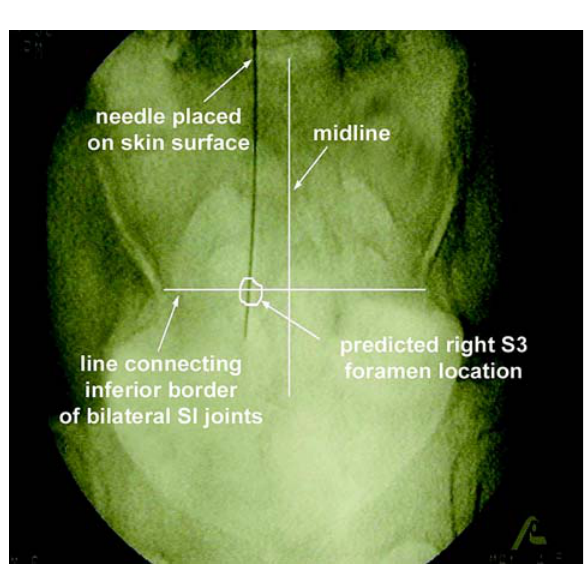
Figure 2 – Localization of S3 Foramen by cross hair technique (from Chai TC, Mamo GJ: Modified techniques of S3 foramen localization and lead implantation in S3 neuromodulation. Urology. 2001; 58: 786-90, with permission).